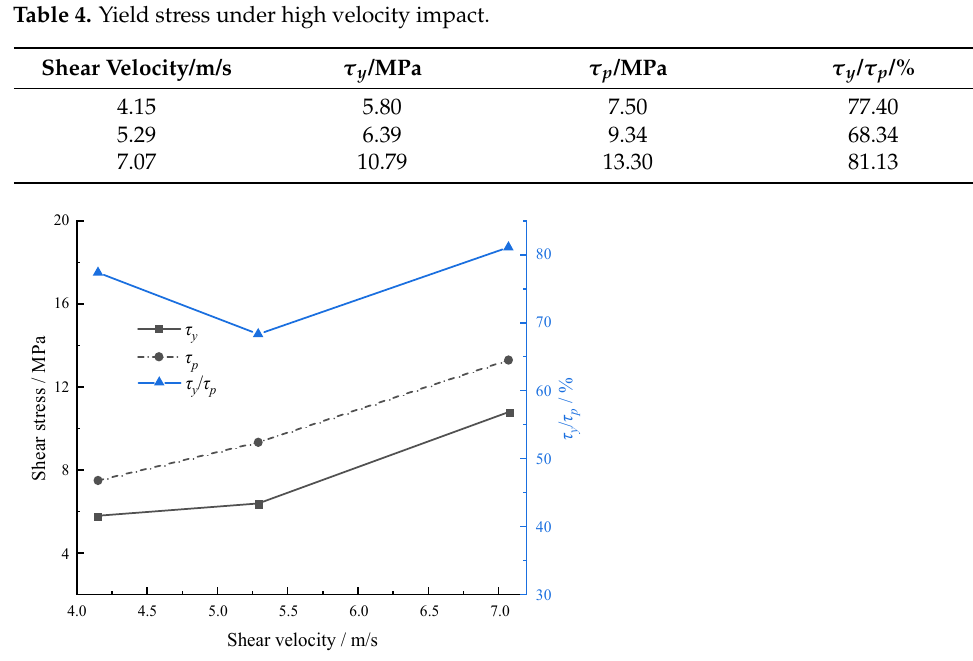
Table 5. Yield stress under various JRC .